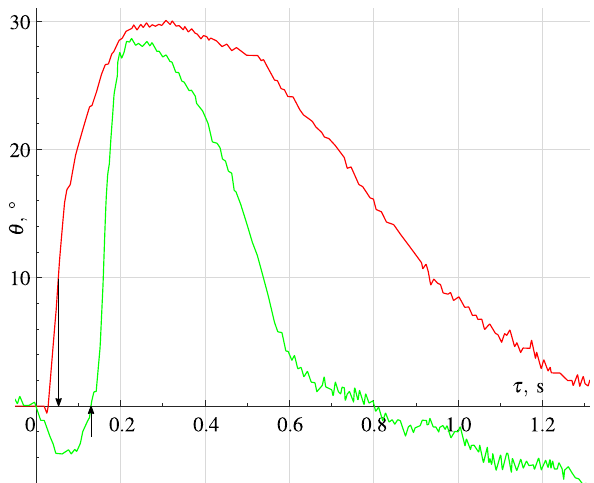
Figure 4. The θ angle variation during a soft push of the disk (green curve). In the experiment on a tinted solution, it was seen that the jets flowing around the disk move in the opposite direction at a higher speed than the disk itself. A red curve refers to the same but in response to a sharp hit on the pusher. The jet flow differs from the previous observation. For both curves, the external force starts to act at zero time and ends at the time marked with the